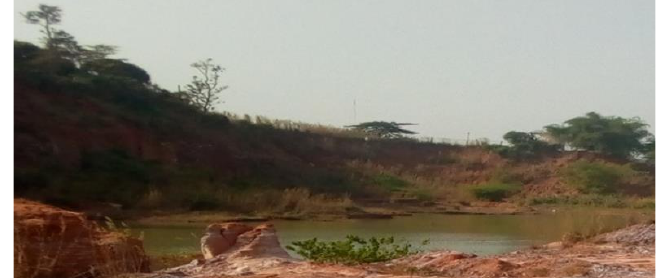
Figure 3: Water Pond Developed as a Result of Excessive and